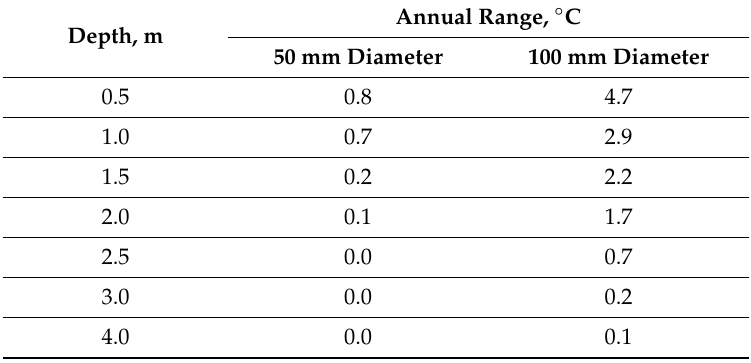
Table 3. Annual range of temperature departures in the boreholes cased with polyethylene pipes 50 and 100 mm in diameter,